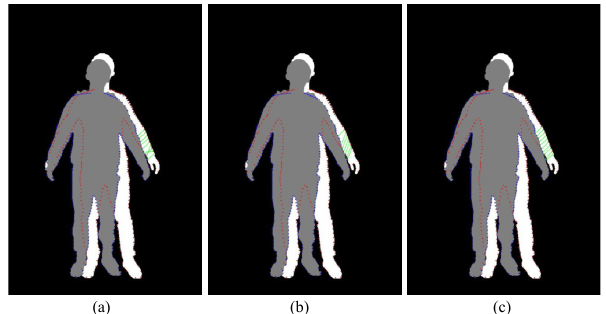
Fig. 4 Failure of matching using shape contexts [34]: (a) cross matching, (b) part shifting, and (c) correct matching.